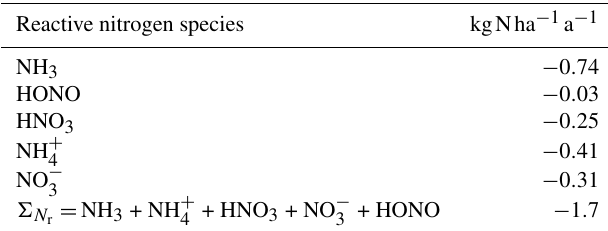
Table 4. Contribution of reactive nitrogen species to total ( (cid:54) (NH 3 + NH + budget for ATTO inkg Nha − 1 a − 1 , inferred from fluxes measured during the